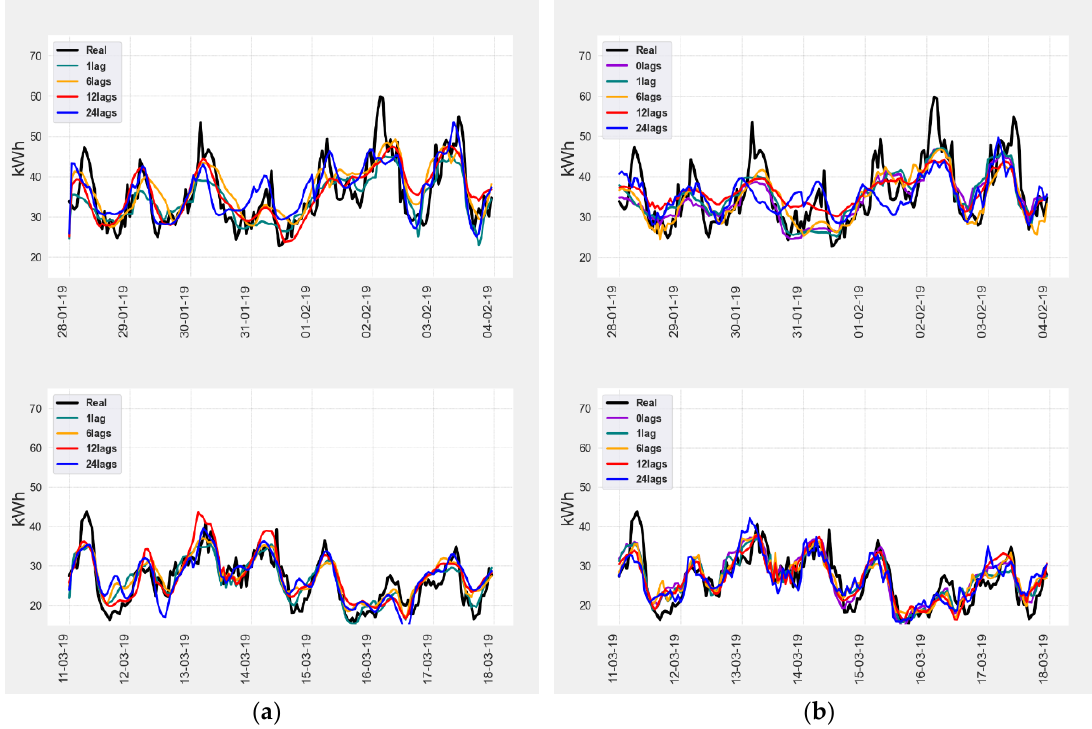
Figure 4. Results of thermal demand predictions in sample 1 (upper side) and sample 2 (bottom side) considering the different structures of time lags. Each architecture is represented by the prediction curve with the lowest error among the 10 repetitions: ( a ) LSTM models; ( b ) MLP models.